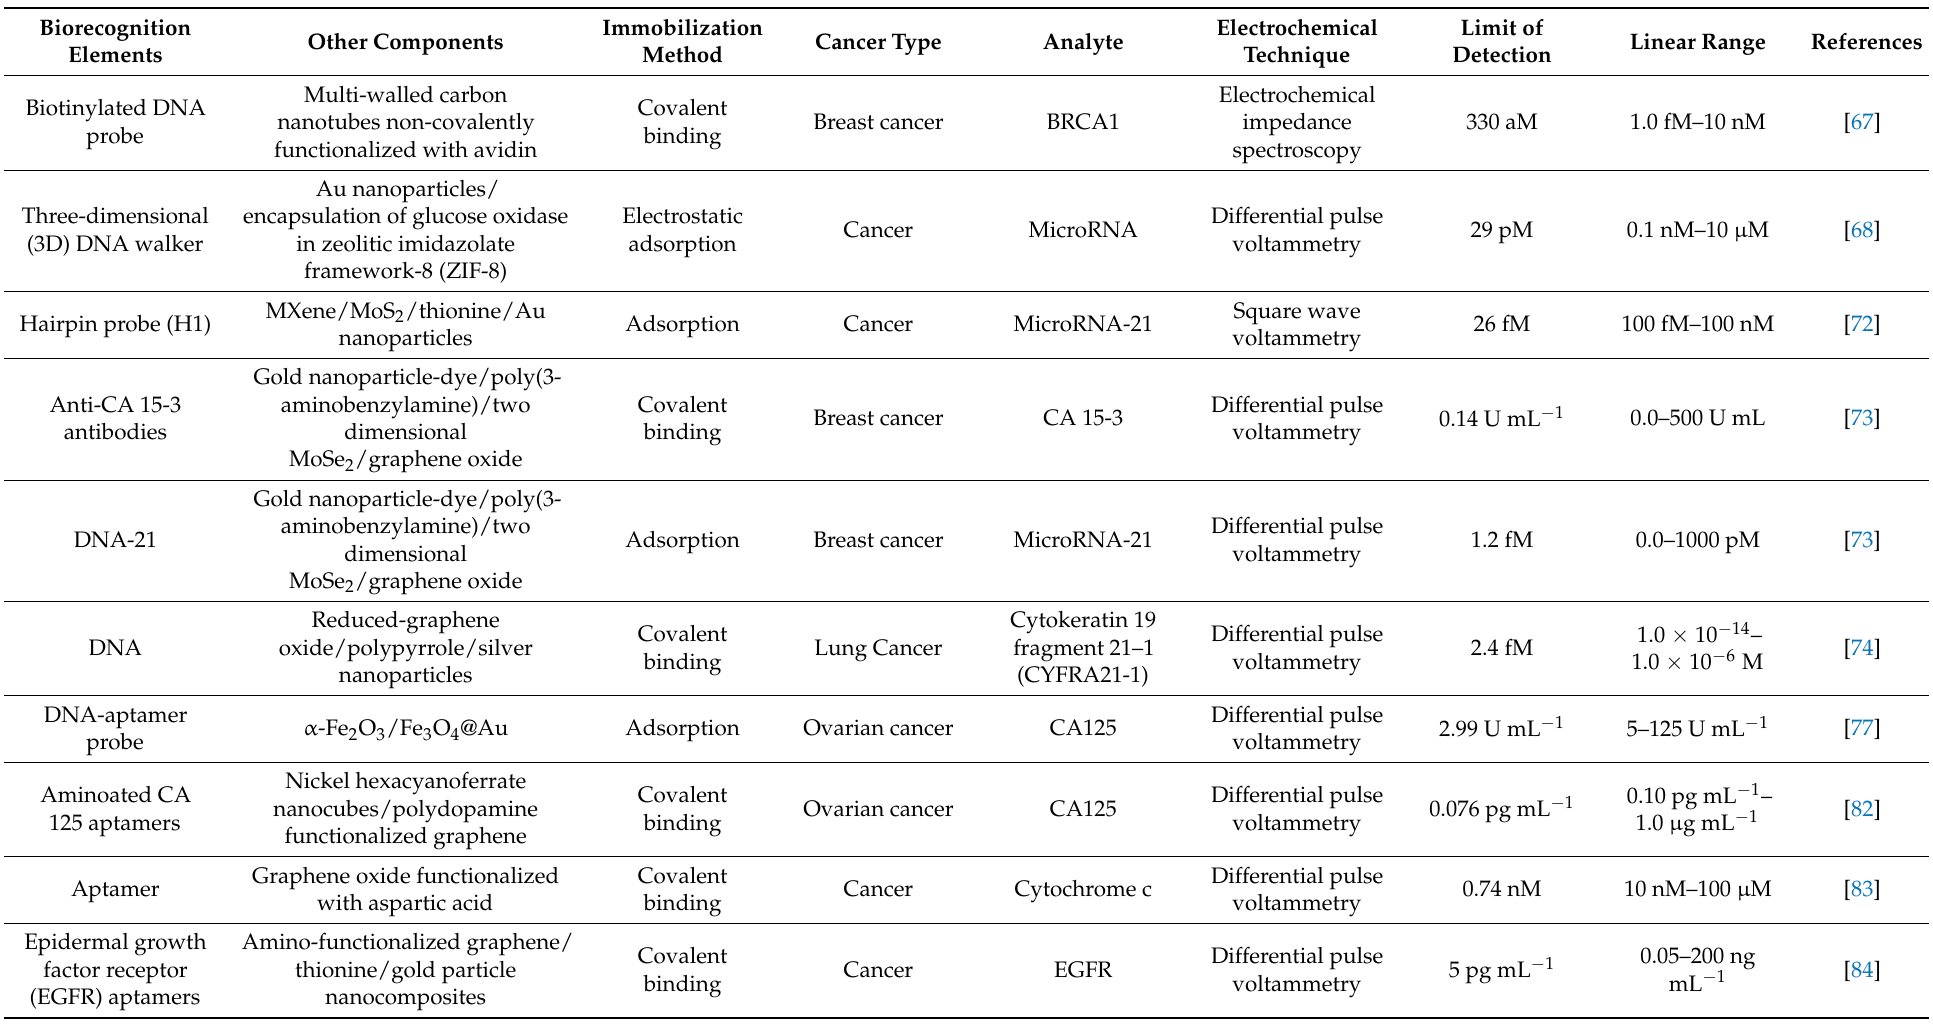
Table 1. Electrochemical-based label-free biosensors for cancer detection: biorecognition elements, sensor platforms, immobilization methods and electroanalytical